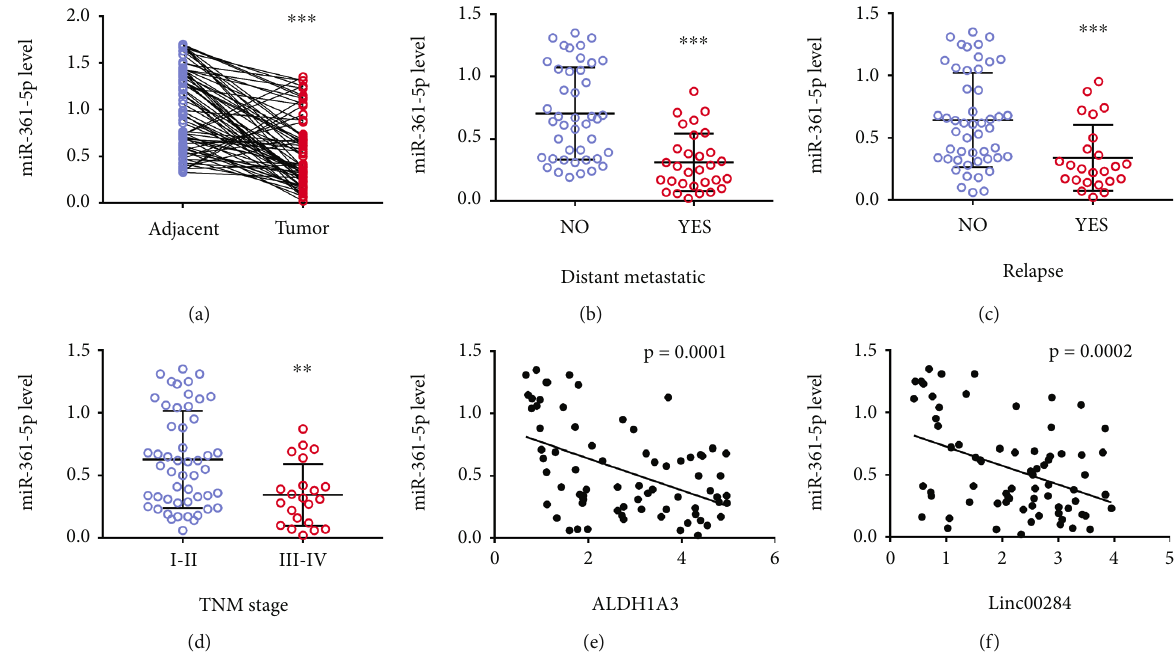
Figure 6: Expression of ALDH1A3 – Linc00284-mediated miR-361-5p was associated with the clinicopathological characteristics in patients with colorectal cancer. (a) The expression level of miR-361-5p in 73 human CRC samples and paired adjacent normal tissues ( n = 73 ). The expression level of miR-361-5p was signi fi cantly lower in tumor tissues of (b) patients with metastatic CRC ( n = 43 ) than those without metastasis ( n = 30 ) or (c) patients with relapse CRC ( n = 49 ) compared with those without relapse CRC ( n = 24 ) or (d) patients with stage III – IV CRC ( n = 51 ) than those with stage I – II CRC ( n = 22 ). The correlation between miR-361-5p and ALDH1A3 (e) and Linc00284 (f) was analyzed by the Pearson correlation test in 73 human CRC